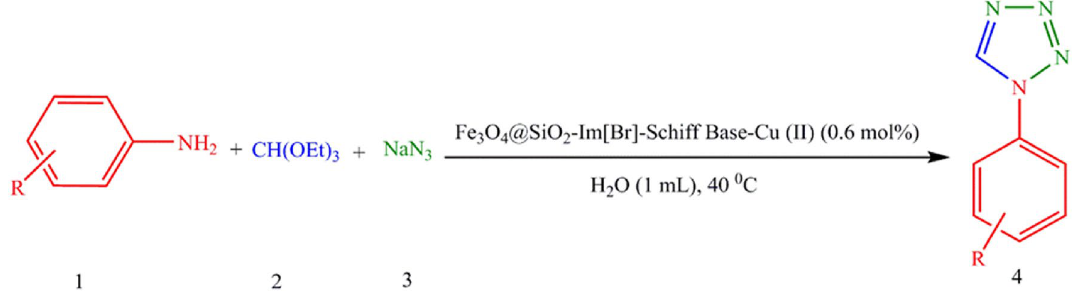
Figure 11. The synthesis of 1-aryl 1 H -tetrazole